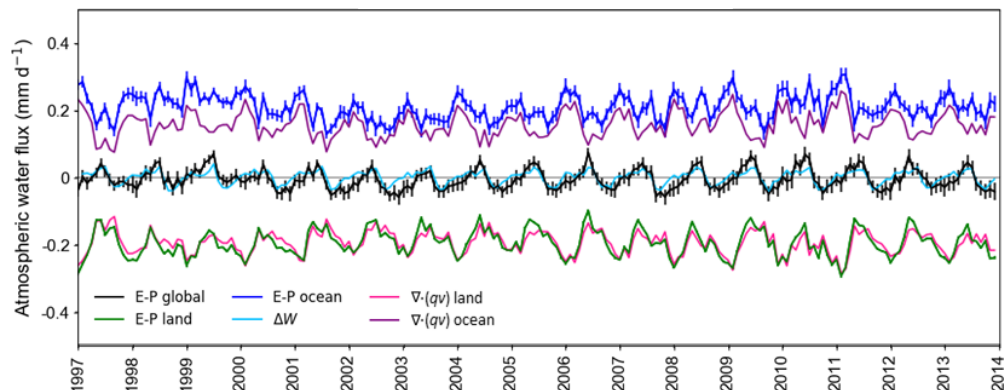
Figure 7. ERA5 monthly mean E − P over the whole globe (black), land only (green), and ocean (blue); global mean (cid:49)W (light blue), and mean ∇ · (vq) over land (pink) and ocean (purple). The mean values over the globe and land were scaled by their surface area relative to the ocean surface area (i.e., they were multiplied by 510 / 350 and 160 / 350, respectively) to obtain consistency with the over-ocean means shown in Fig. 3. Error bars represent the standard deviation within the 10-member ensemble, which is smaller than the graph’s line width for E − P over land, (cid:49)W , and ∇ · (vq) .